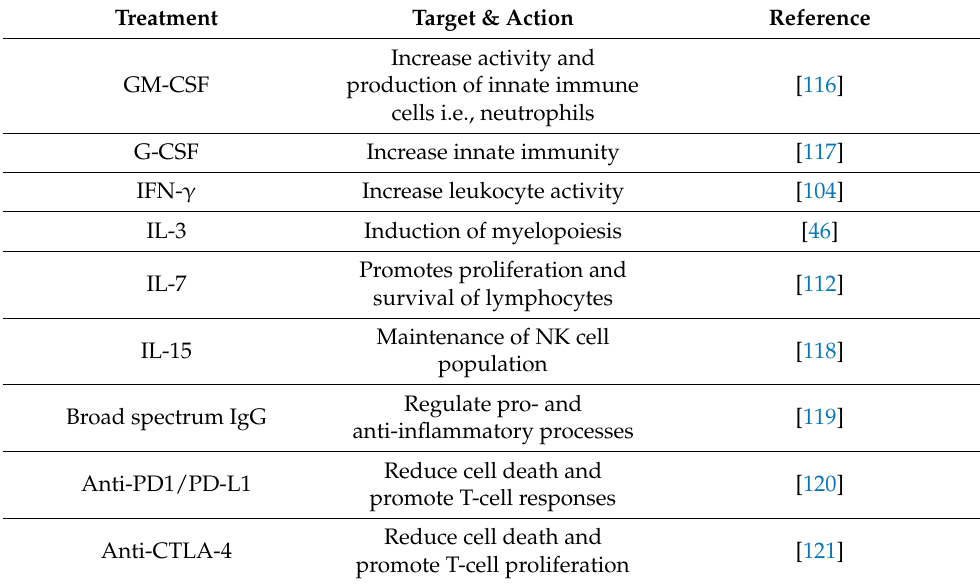
Table 1. Putative treatment strategies that aim to reduce immunosuppression during sepsis.